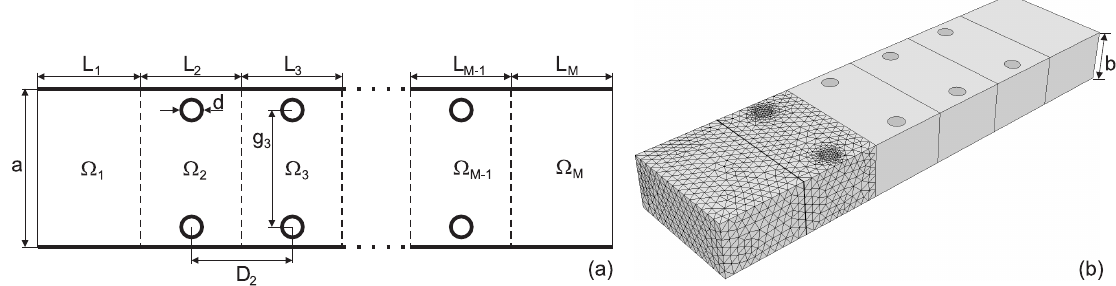
Figure 2. The test structure—rectangular waveguide loaded with pairs of metallic cylindrical posts in E-plane and divided into M subdomains Ω 1 . . . Ω M . The dimensions are shown in x-z plane view ( a ). The waveguide height is b . The perspective view ( b ) for M = 6 shows that the mesh is generated in Ω 1 and Ω 2